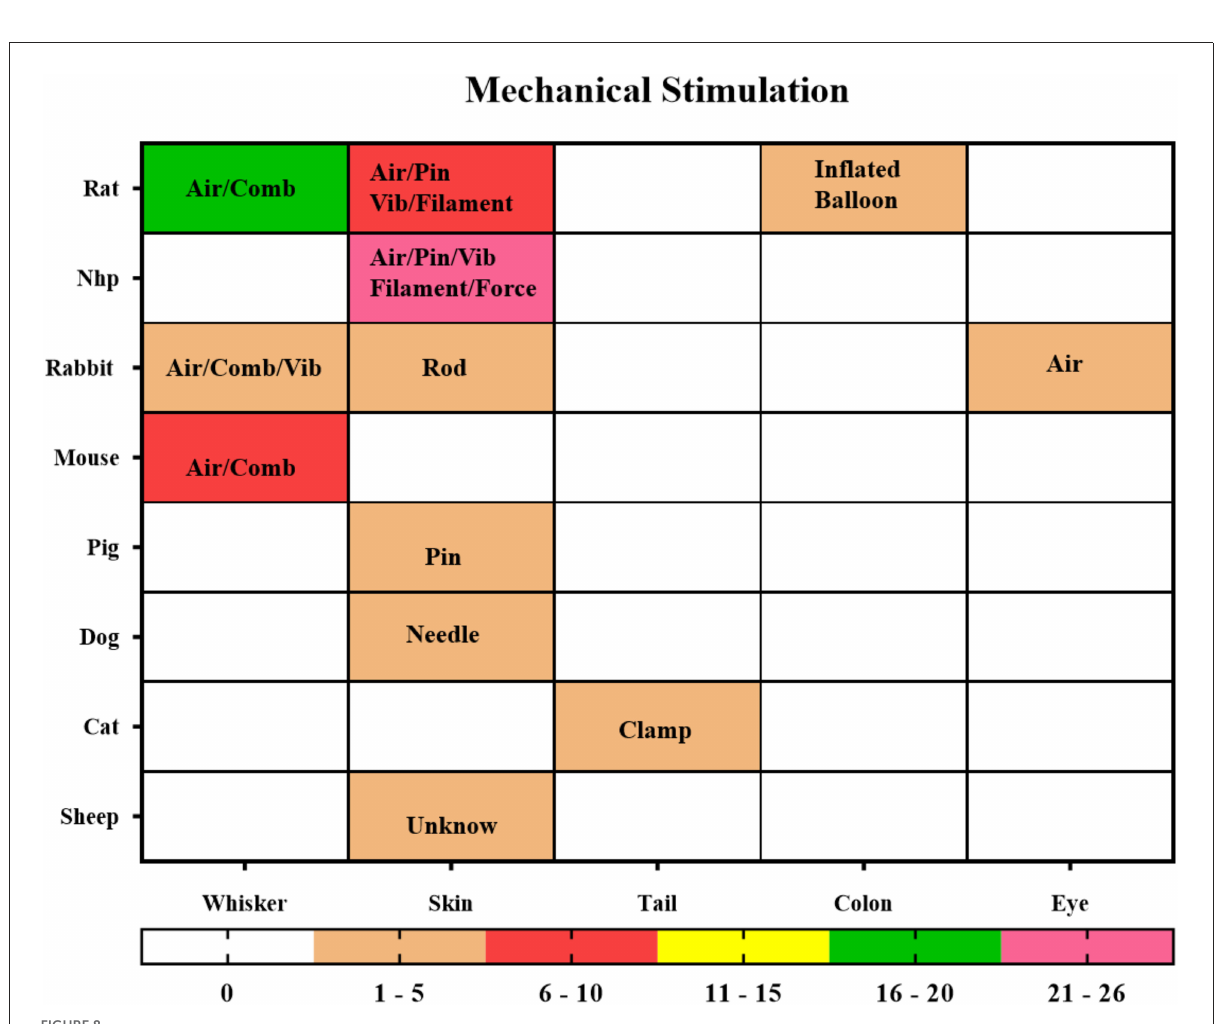
FIGURE8 Mechanical Stimulation. The locations of stimuli and species distribution are displayed through a hotspot map, and the content in the hotspot grid is the medium used to apply the stimuli, including air, pin, vibrator (Vib), filament, force, clamp, comb, balloon. The color bar means the number of